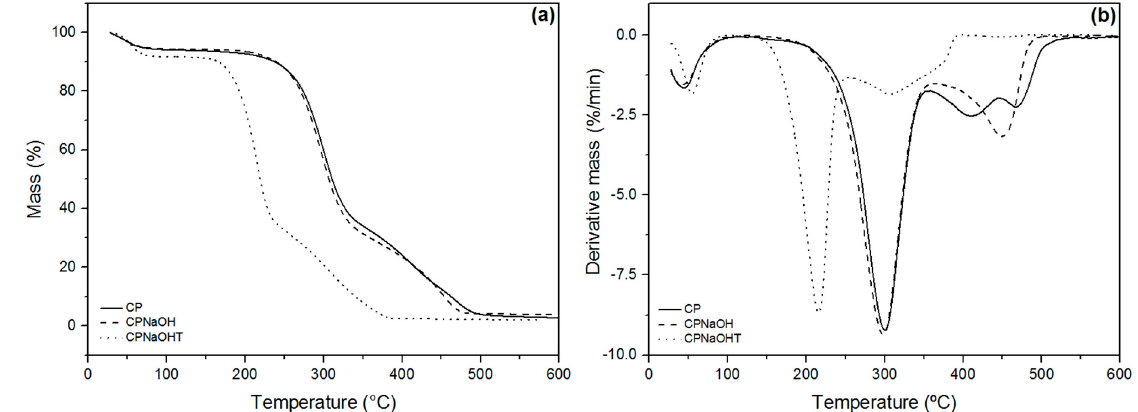
Figure 11. Thermogravimetry ( a ) and Derivative Thermogravimetry ( b ) curves of CP, CPNaOH, and CPNaOHT.